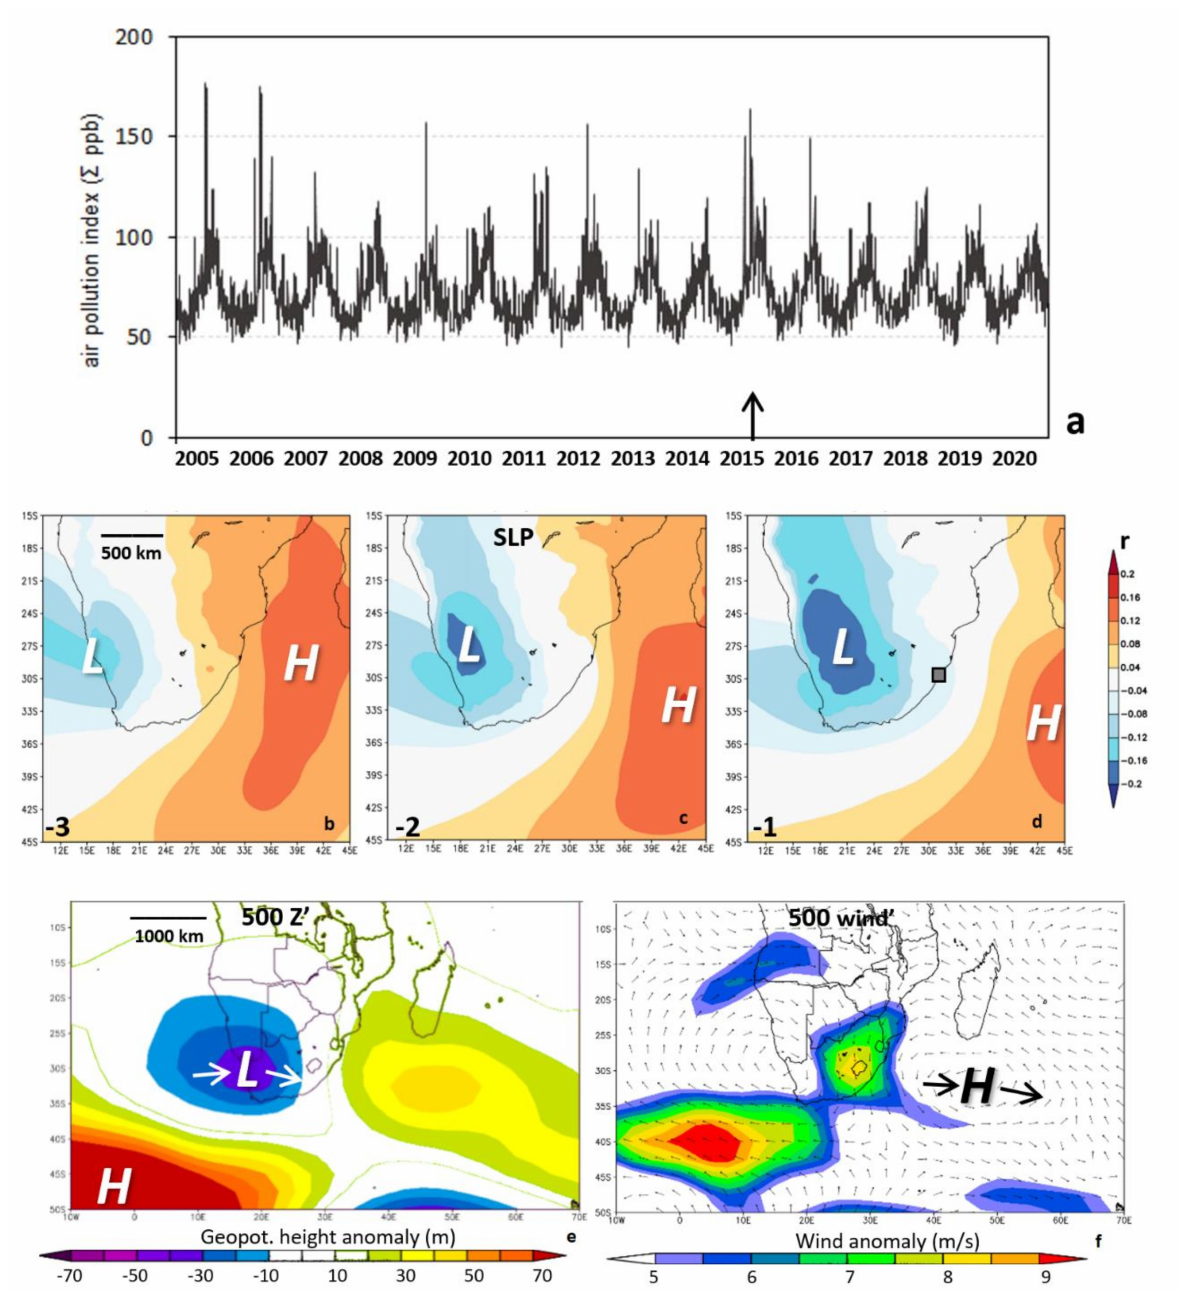
Figure 4. ( a ) Time series of daily cumulative API over Durban ( Σ ppb). Point-to-field correla- tions (May–August 2005–2020) with respect to daily API for ERA5 sea-level pressure (SLP): ( b ) − 3, ( c ) − 2, ( d ) − 1 days before high air pollution in Durban (N = 1920). Composite anomalies of the top-10 air pollution days: ( e ) 500 hPa geopotential height and ( f ) winds illustrating a Kalahari trough and Mascarene high (arrows refer to movement from day –1 to day